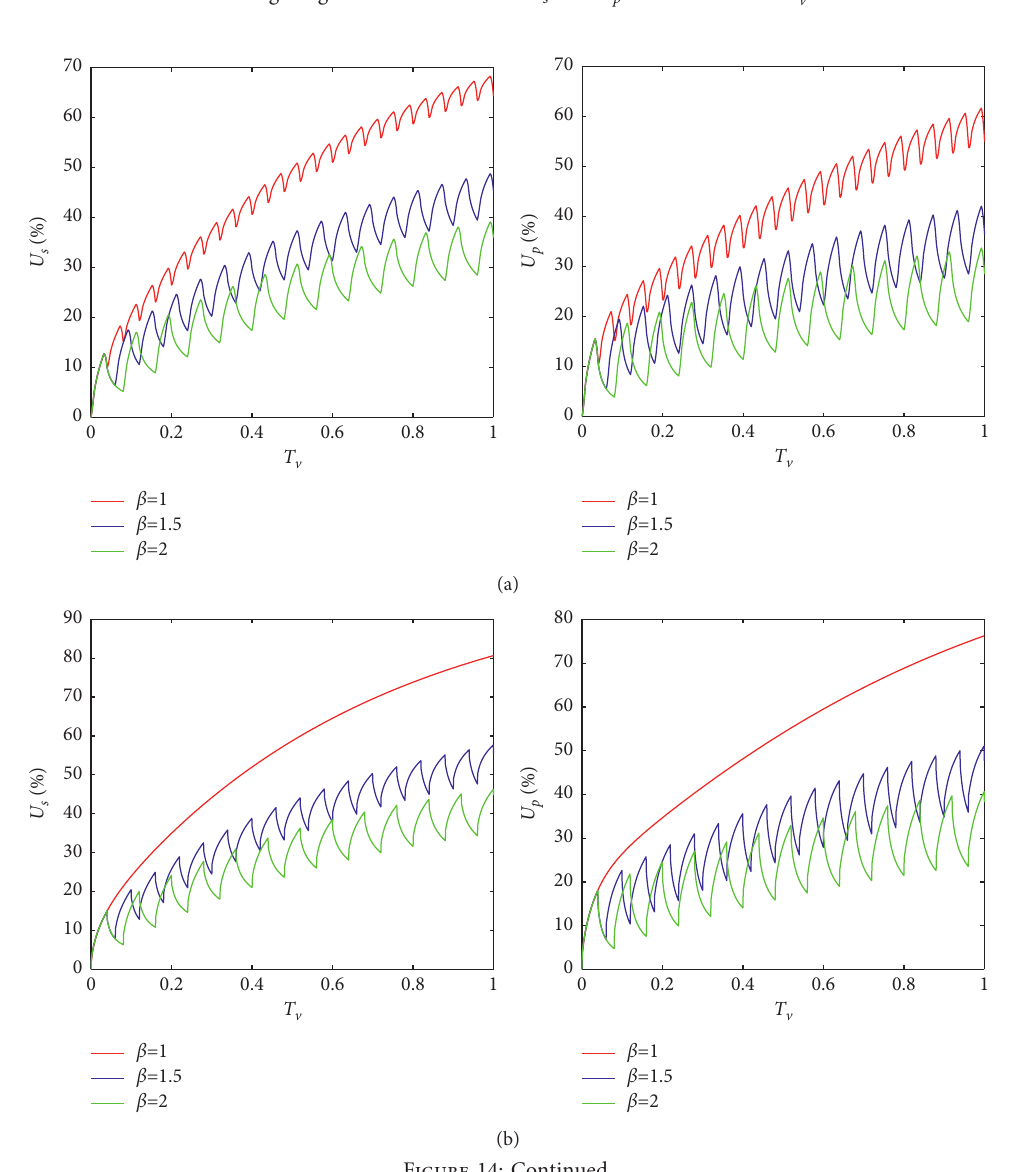
T v under different values of α s and U p with time factor